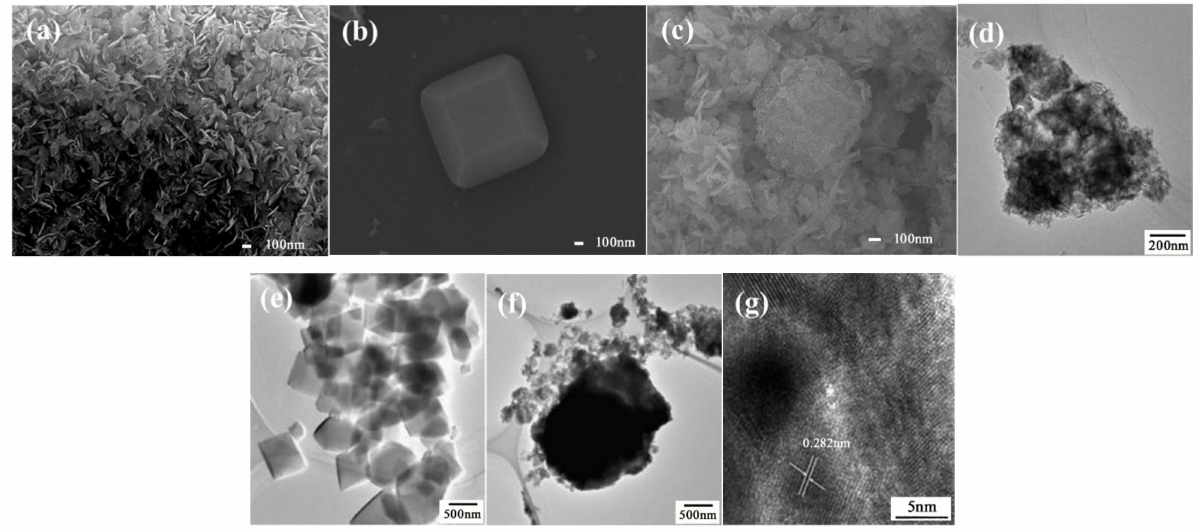
Figure 3. SEM images of ( a ) BiOI, ( b ) NH 2 -MIL-125(Ti), and ( c ) BNMT-9. TEM images of ( d ) BiOI, ( e ) NH 2 -MIL-125(Ti), ( f ) BNMT-9, and ( g ) HRTEM of BNMT-9.